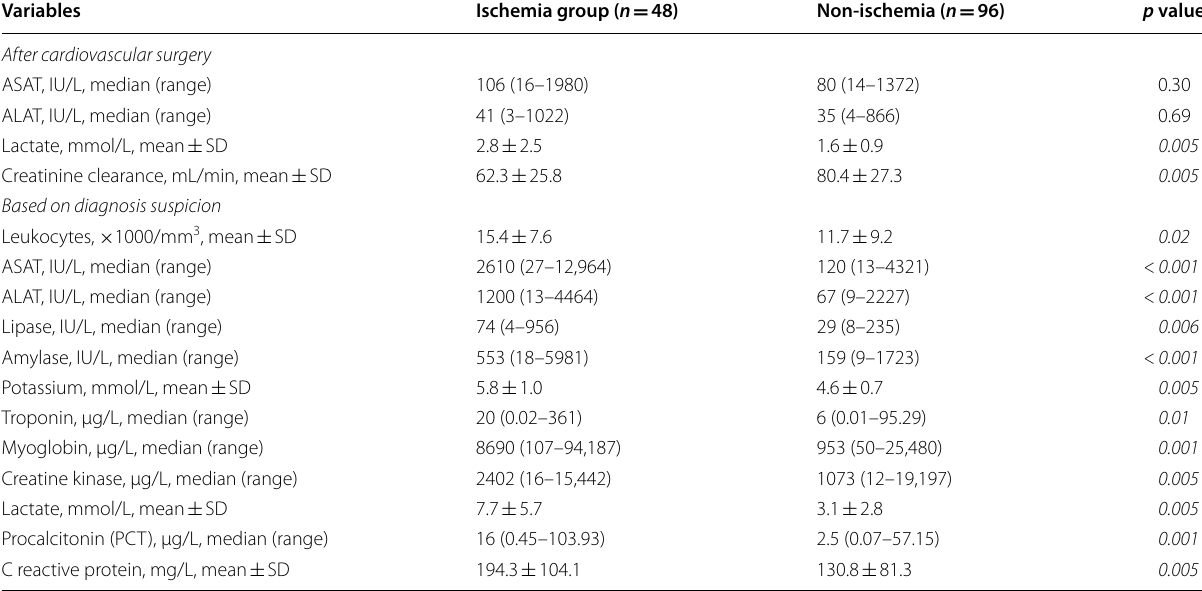
Table 2 Biological features for the diagnosis of acute bowel